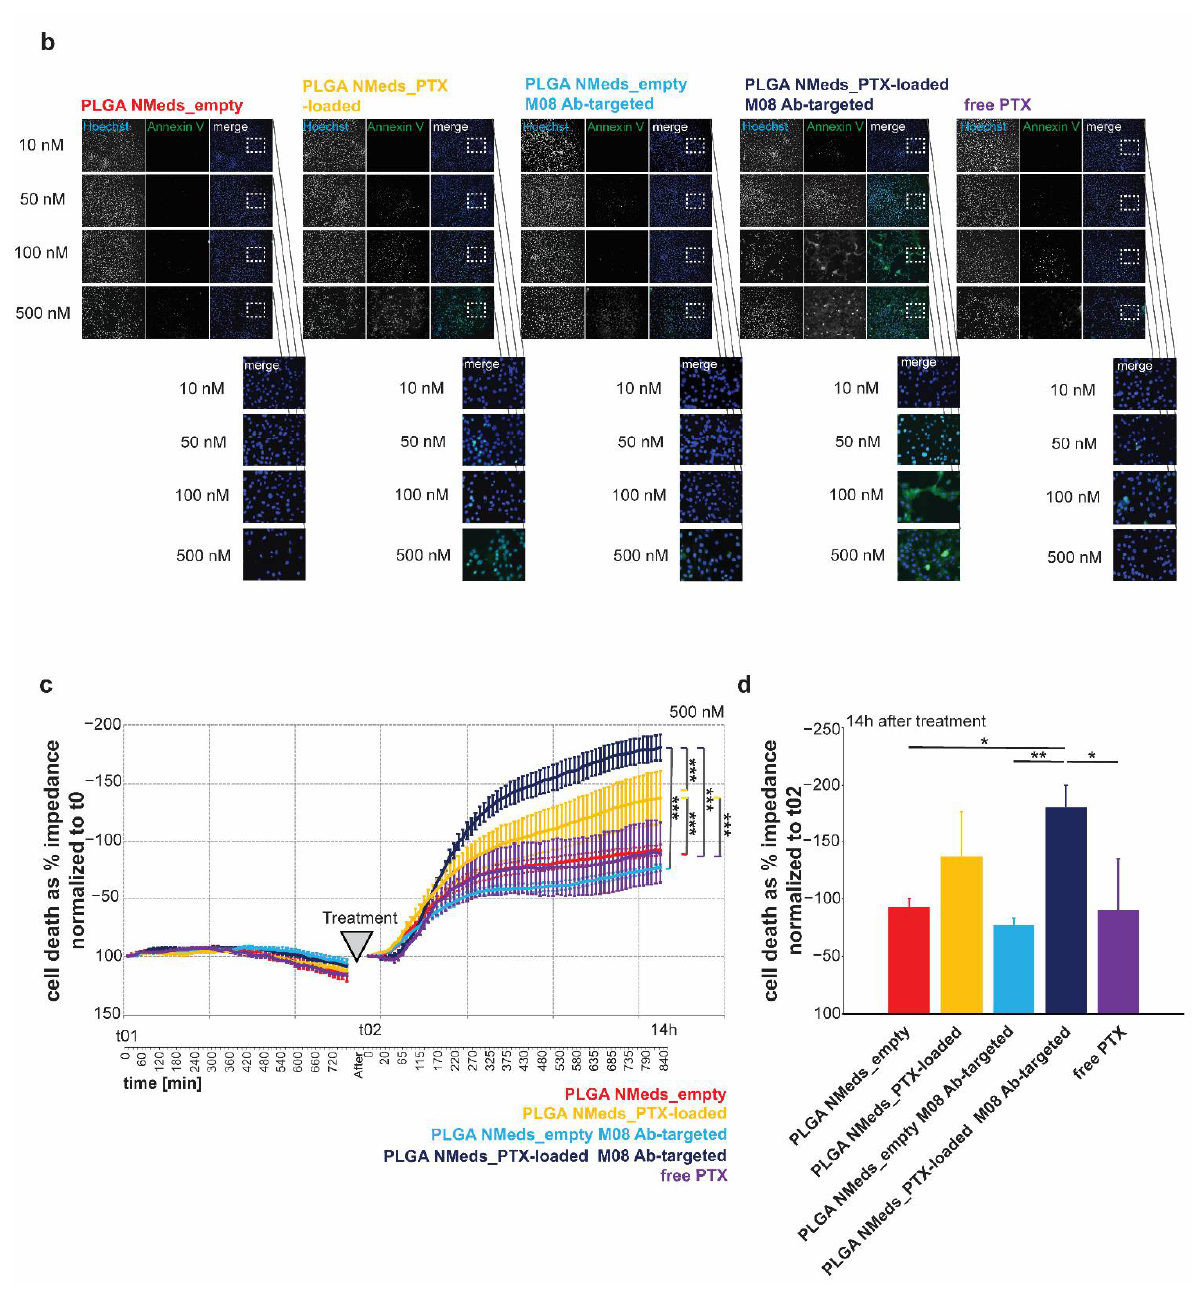
Figure 6. Effect of PTX-loaded NMeds on cell health of C6 glioblastoma cells. ( a ) Quantification of apoptosis using FITC-Annexin V. The percent of Annexin V positive cells of total cells is shown as average from n = 3 OFV. C6 cells were treated for 3 h with empty non-targeted and M08-targeted NMeds, and non-targeted and M08-targeted NMeds delivering the equivalent of 10, 50, 100, and 500 nM PTX. Free PTX at the same concentrations was used as controls. ( b ) Representative images showing all cells. The visualisation was achieved by labelling the nuclei with Hoechst staining and labelling apoptotic cells with Annexin V-FITC. ( c , d ) Cell impedance measurement after treatment with empty non-targeted and M08-targeted NMeds, as well as their PTX loaded counterparts (the equivalent of 500 nM PTX) and compared with500 nM free PTX as a control treatment. Before treatment, cells were grown for 12.5 h (t0 1 —750 min). n = 3 per treatment. Cell death was evaluated as a decrease in impedance and shown as % of t0. ( d ) Cell death analysis at the 14 h endpoint of the treatment shown in ( c ). One-way ANOVA analysis and Tukey’s Post hoc tests were performed, * p < 0.05, ** p < 0.01, *** p <